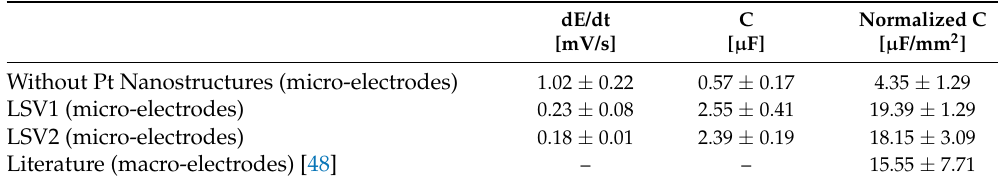
Figure 3. Current reversal chronopotentiometry (CRC) measurements of the different fabricated Li + ISEs on micro-electrodes: without platinum nanostructures and with platinum nanoflowers deposited by LSV1 and LSV2. Table 1. Potential drift and capacitance values obtained from the Current reversal chronopotentiometry (CRC) measurements of the different fabricated Li + ion-selective sensors (ISE) on micro-electrodes in comparison with the literature values on